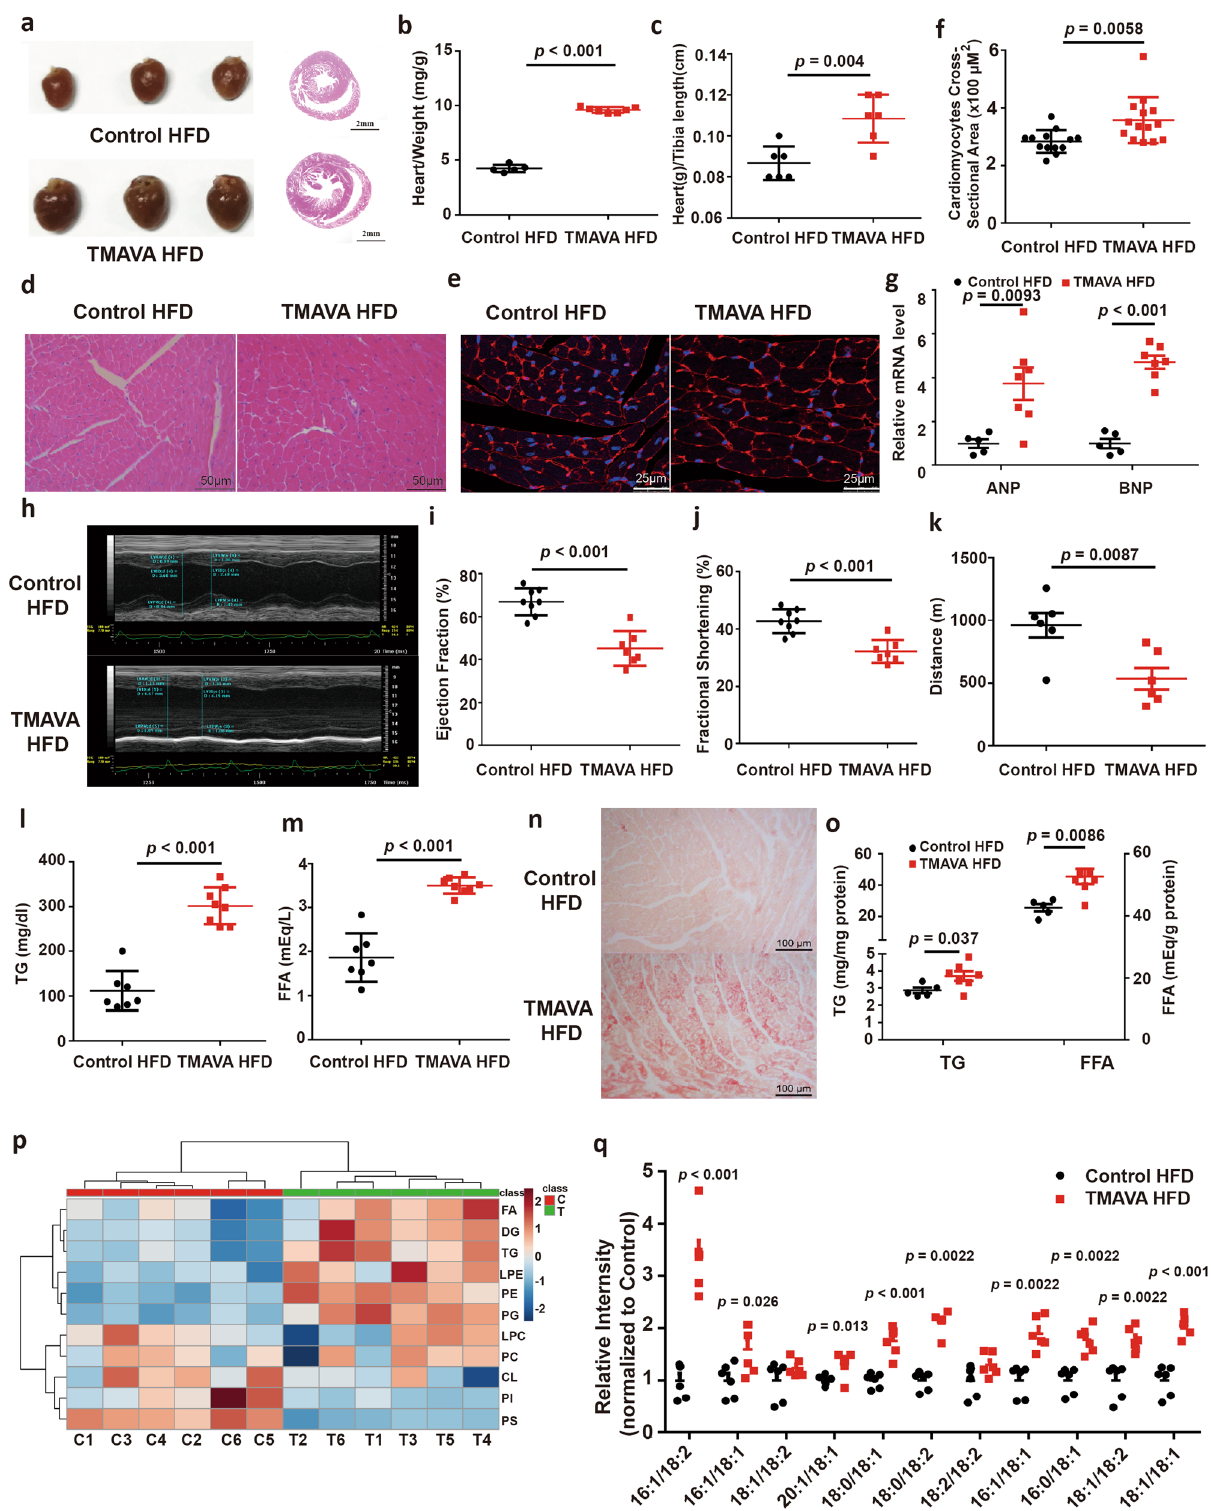
FAO is impaired in TMAVA treated hearts . To investigate whether TMAVA treatment affects myocardial energy metabo- lism under the HFD condition, we assessed the rates of FAO in the two groups of mice. Mitochondrial FAO was decreased in the TMAVA-treated mice (Fig. 4d). In the treadmill exhaustion test, likely due to insuf fi cient amounts of FFA being oxidized as